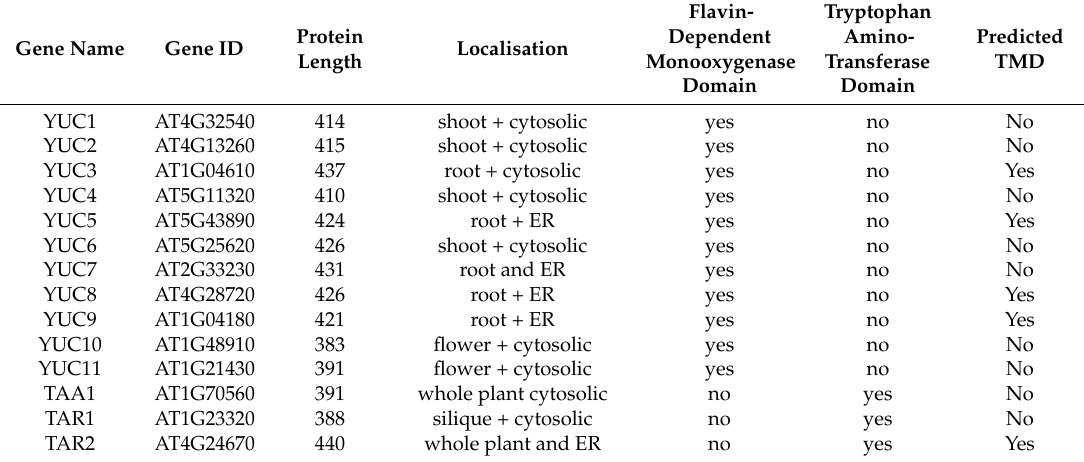
Table 2. Reference genes used in the study. The table summarizes information on the protein localisation in the plant and predicted protein domains